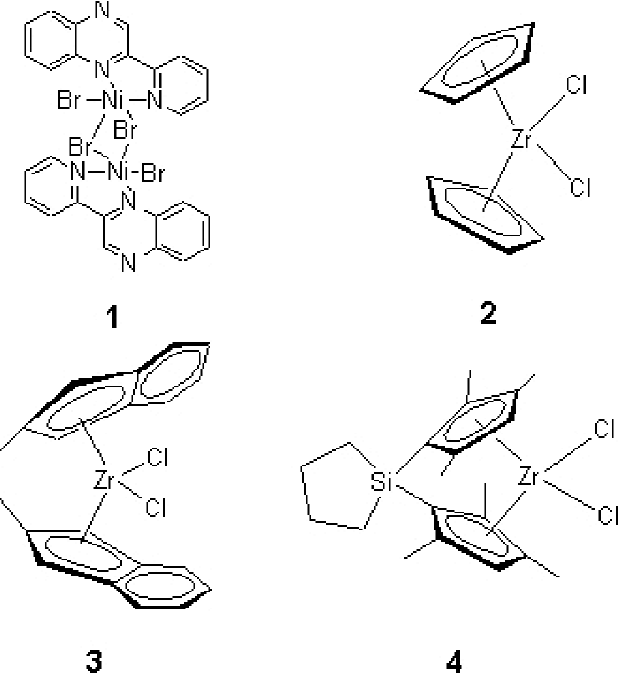
Fig. 1 The structure of the Ni and Zr